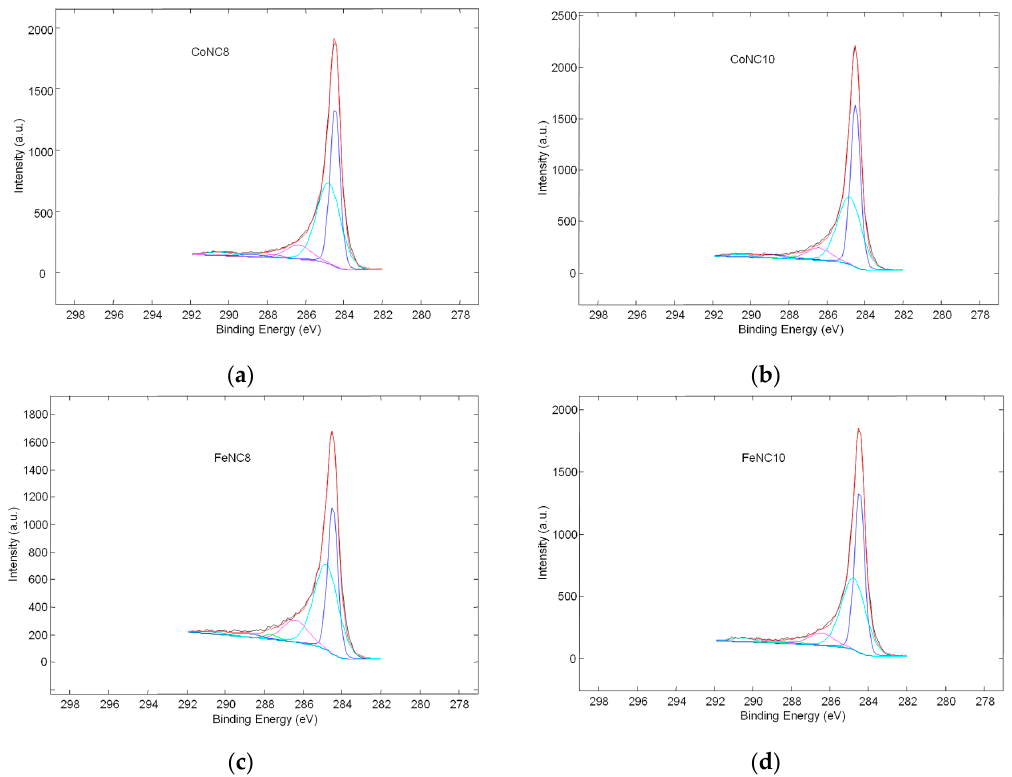
Figure 4. Deconvolution of C 1s high-resolution XPS spectra for the following catalysts: ( a ) CoNC8; ( b ) CoNC10; ( c ) FeNC8; and ( d ) FeNC10.